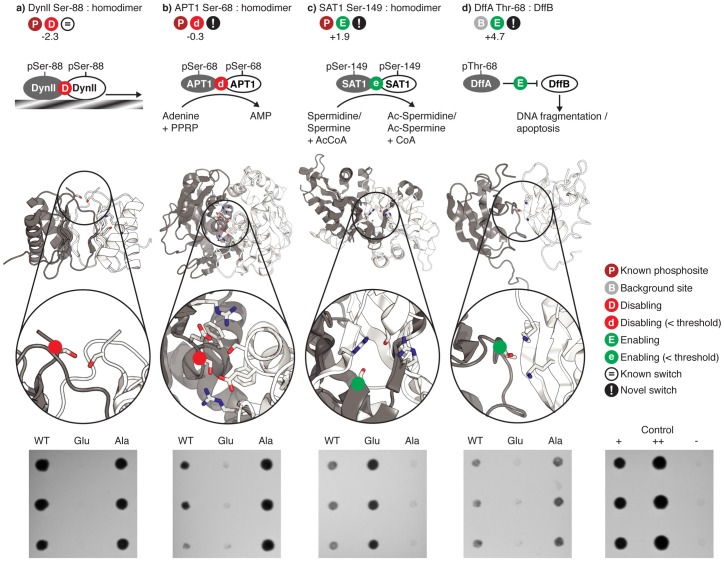
Experimental verification of known and predicted phosphoswitches using wild-type (wt), Glutamate and Alanine mutants in the yeast two-hybrid system.Phosphorylated proteins are shown in grey and the proteins with which they interact are shown in white. The sidechains of phosphosites and the residues with which they interact are shown as sticks coloured by atom type. Phosphosites are indicated by coloured dots on C-alpha atoms. Sswitch scores are shown besides enabling or disabling symbols. a) the known disabling site Ser-88 in human Dynein [40] is observed to be disabling, with wild-type and Alanine mutants growing but not the Glutamate mutant. b) Phosphorylation of Ser-68 in yeast Adenine phosphoribosyltransferase (APT1) was predicted to weakly disable the homodimer interaction by contacting itself and other charged residues in the homodimeric interface [55], which is required for conversion of Adenine to AMP, and a disabling effect was observed. c) Phosphorylation of Ser-149 in human diamin acetyltransferase 1 (SAT1) was predicted to enable formation of homodimers [56] required for spermidine/spermine acetylation and was observed to be enabling (wild-type shows growth, Glutamate mutants show stronger growth, Alanine mutant shows no growth). d) Mouse DNA fragmentation factor A (DffA) binds to DffB, inhibiting DNA fragmentation. Phosphorylation of Thr-68 of DffA is predicted to enable interactions with DffB through contacts with two Lysines [57] but is observed to be disabling (wild-type and Alanine mutants show growth, Glutamate does not).